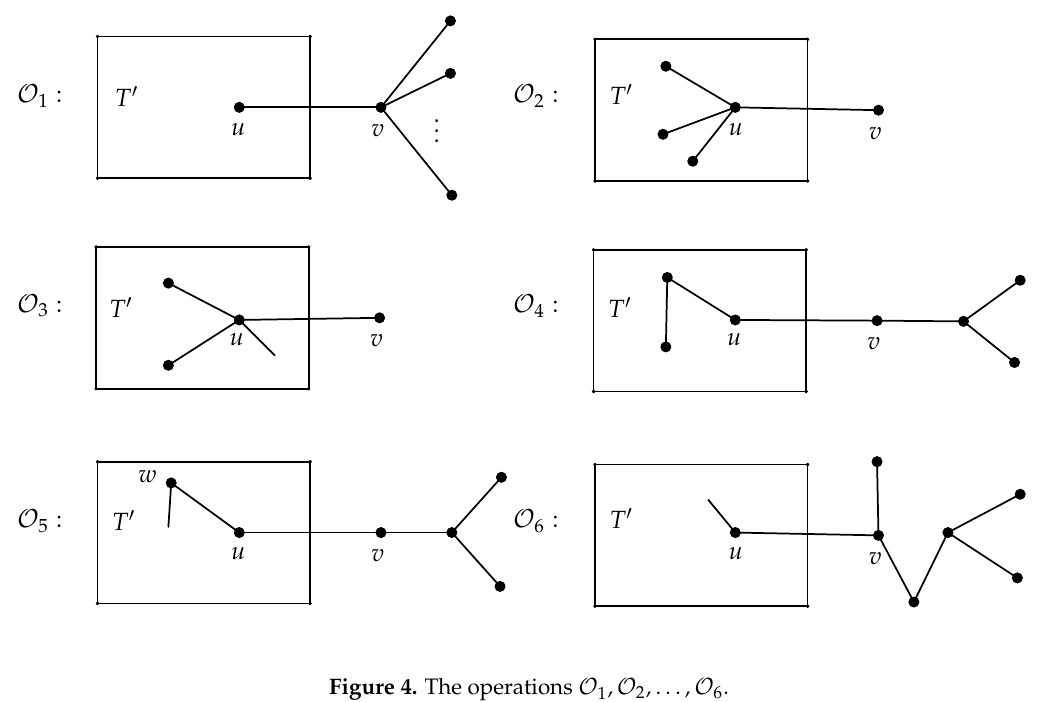
Figure 4. The operations O 1 , O 2 , . . . , O 6 .